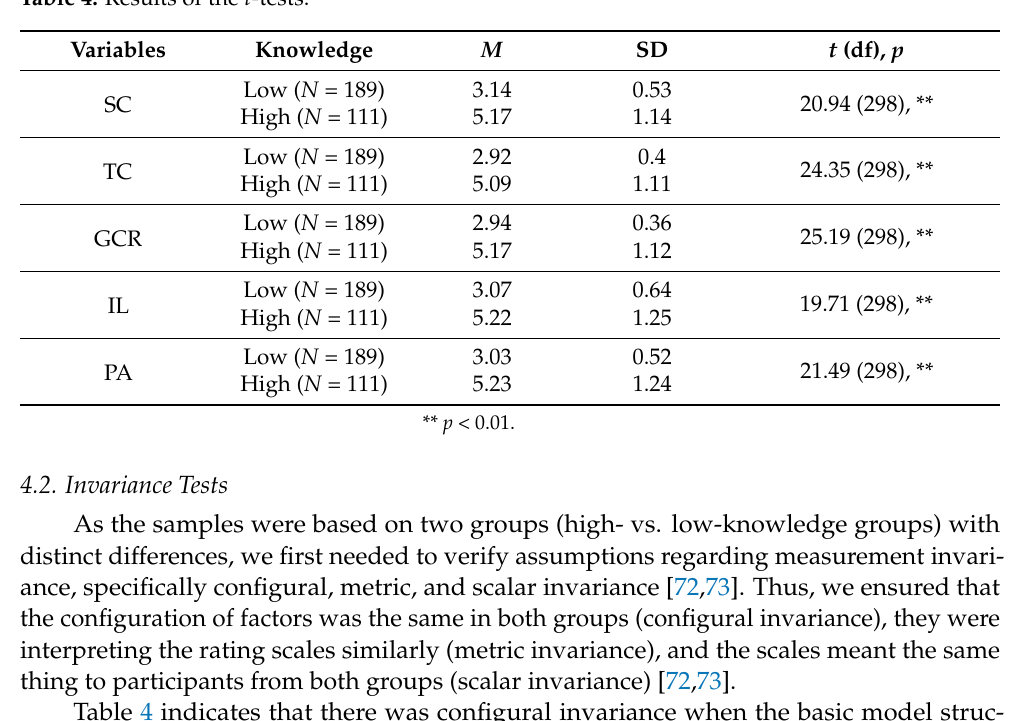
Table 4. Results of the t -tests.